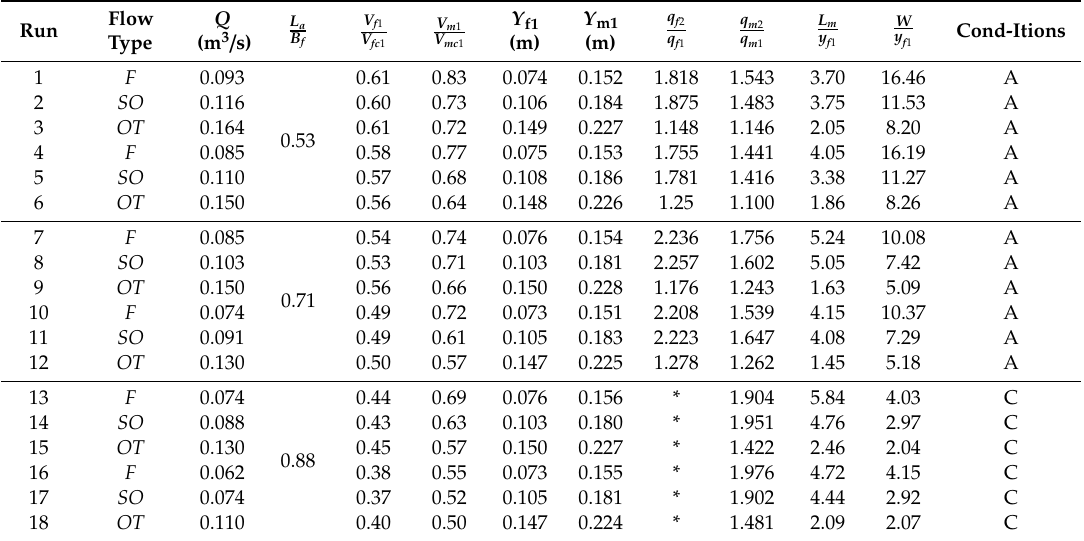
Table 1. Initial experimental parameters and results for location of maximum scour